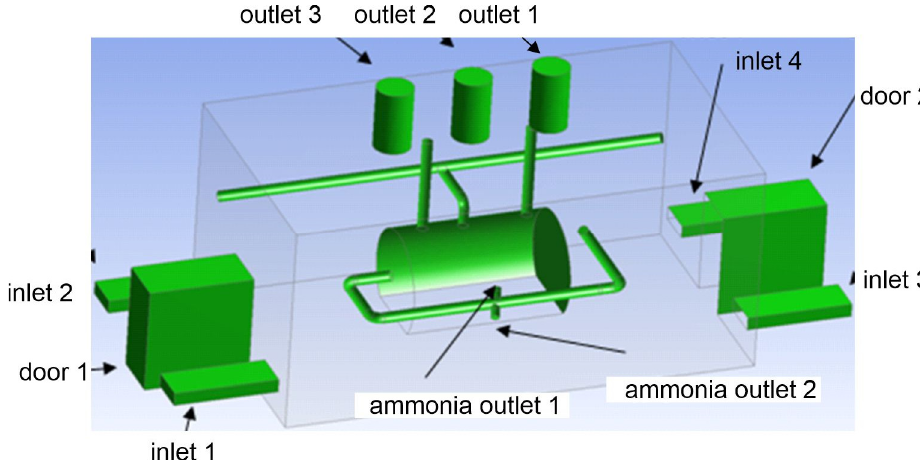
Figure 1. Three-dimensional geometry of the analyzed ammonia machine room.